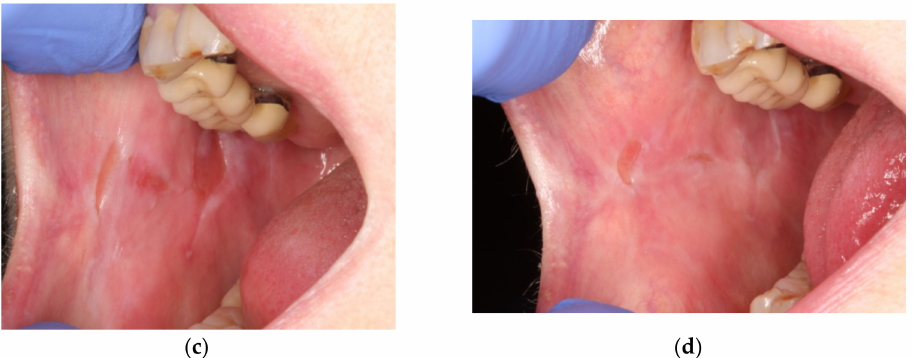
Figure 3. Clinical evolution. ( a ) The lesion after 7 days of the first infiltration. The size of the lesion was slightly reduced. ( b ) Image of the lesion 7 days after the second infiltration. The lesion was more superficial and less painful. ( c ) Seven days after the third infiltration. The lesion was almost resolved. ( d ) One week later. The lesion was resolved at 90%. At this point, we did no more infiltrations.